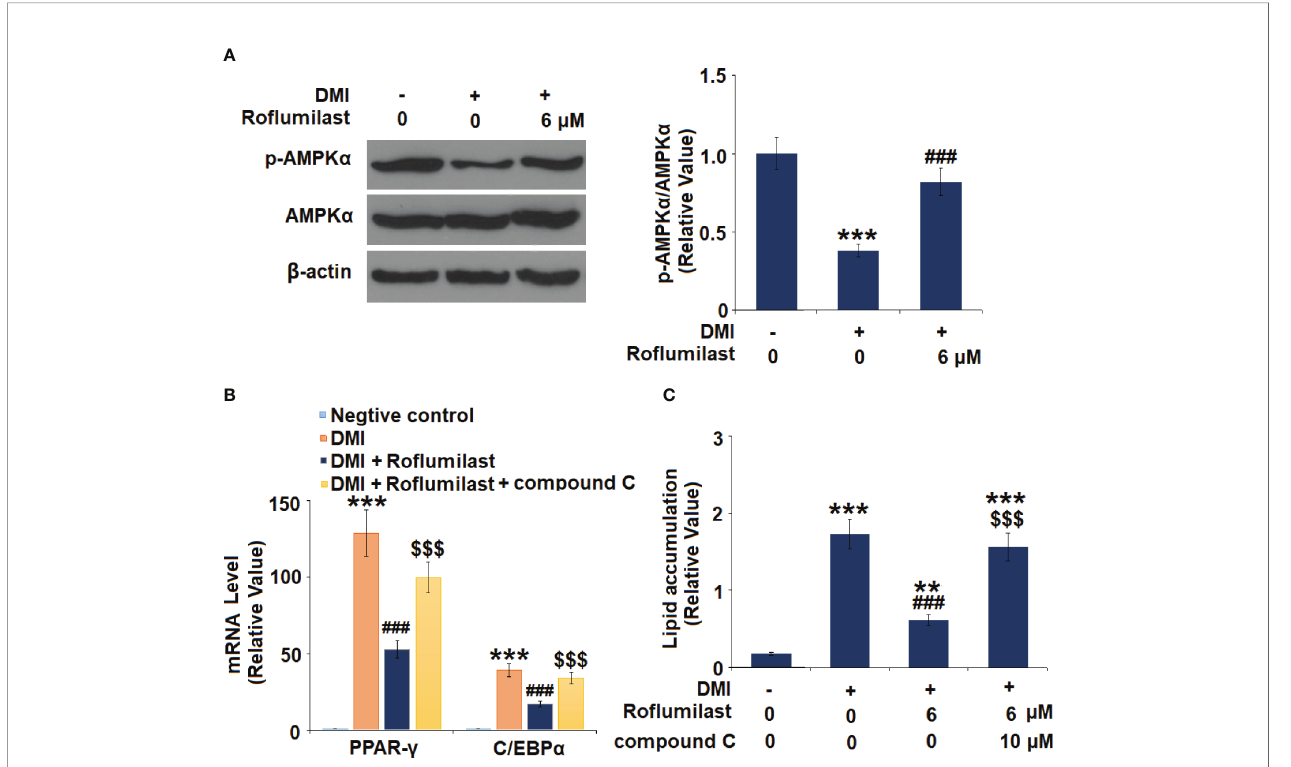
FIGURE 6 | AMPK a mediates adipogenesis. (A) Cells were incubated with a differentiation cocktail (DMI) medium with Ro fl umilast (6 m M). Phosphorylated and total levels of AMPK a were measured, and the representative images of each protein were shown on the top panel, the quanti fi cation of p-AMPK a /AMPK a ratio was shown on the bottom panel; (B) Cells were incubated with a differentiation cocktail (DMI) medium with Ro fl umilast (6 m M) or the compound C (10 m M) for 8 days. mRNA of PPAR- g and C/EBP a ; (C) Lipid accumulation was examined by measuring absorbance at 540 nm of Oil Red O (**, P < 0.05 vs. vehicle group; ***, ### , $$$ , P < 0.005 vs. vehicle, DMI group, and DMI+ Ro fl umilast group, respectively, n =